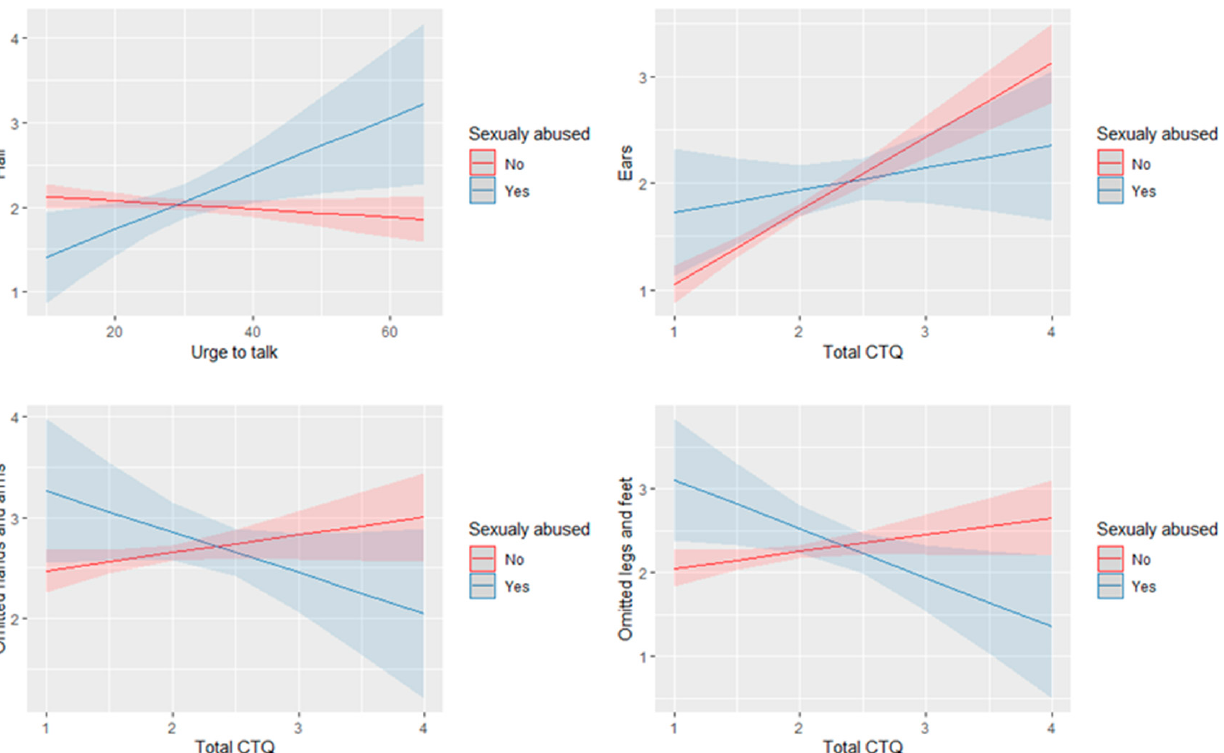
Figure 2. Visualization of significant interaction effect between experiencing CSA and urge to talk score or CTQ total score and the hair, the ear, the omitted hand and arm, and the omitted leg and feet indicators.